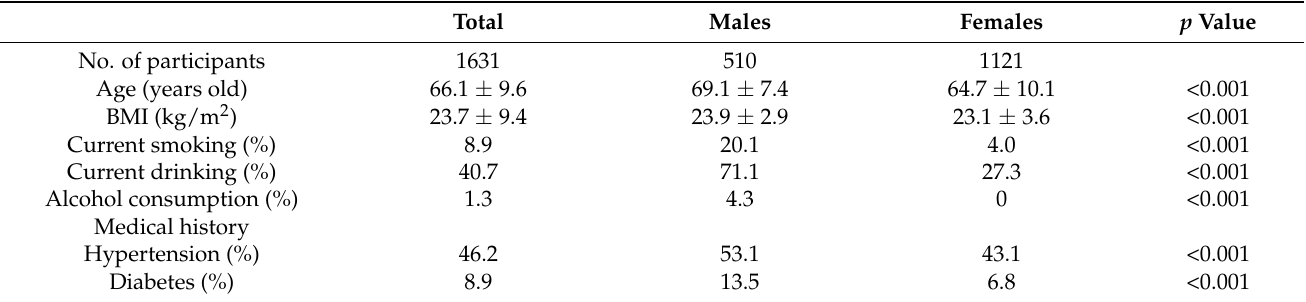
Table 1. The characteristics of